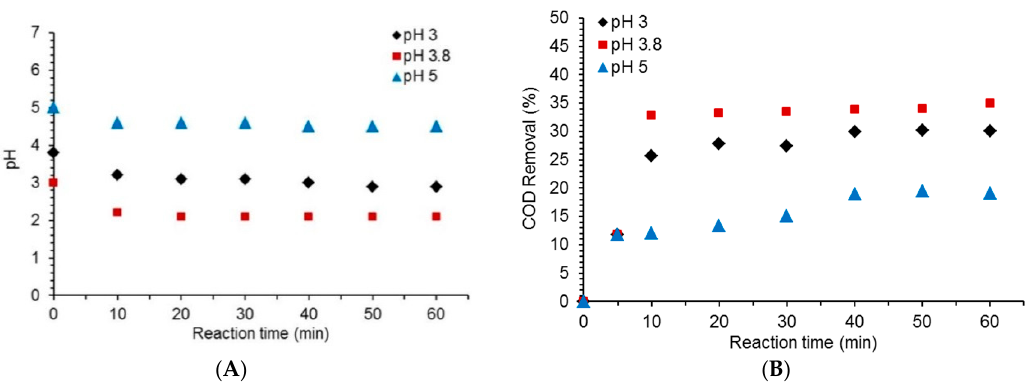
Figure 1. The pH profile ( A ) and removal of chemical oxygen demand (COD) ( B ) by the Fenton reaction at different pH for the ratio of [H 2 O 2 ] to [COD] = 0.12 (g/g) and the ratio of [H 2 O 2 ] to [Fe 3+ ] = 50 (g/g).